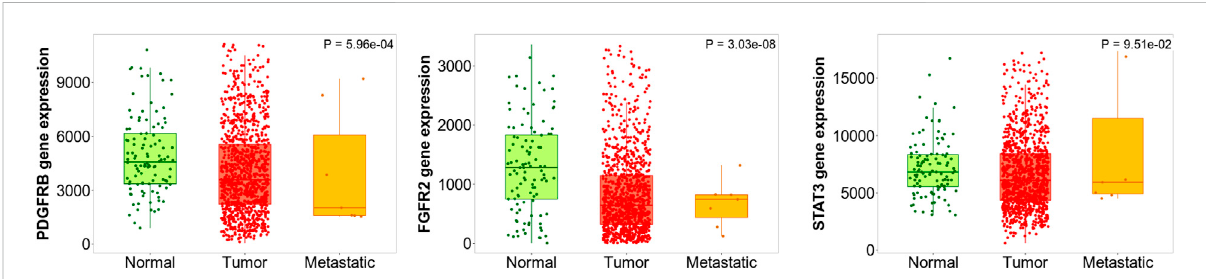
FIGURE 12 Differential gene expression analysis of PDGFRB , FBFR2 , and STAT3 in tumor, normal and metastatic tissues. These genes were identi fi ed to possess the least log-rank test.